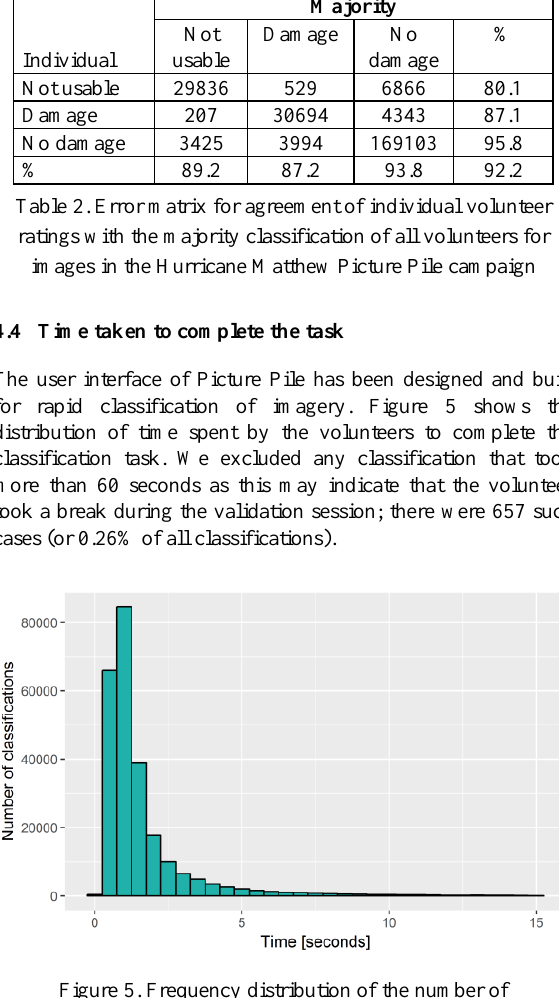
Figure 5. Frequency distribution of the number of classifications by the average time that volunteers spent on the classification